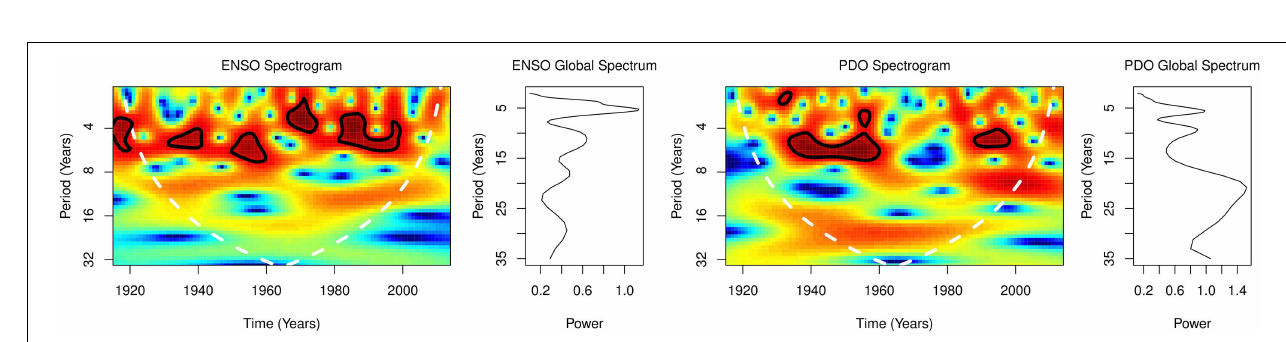
FIGURE 2 | ENSO and